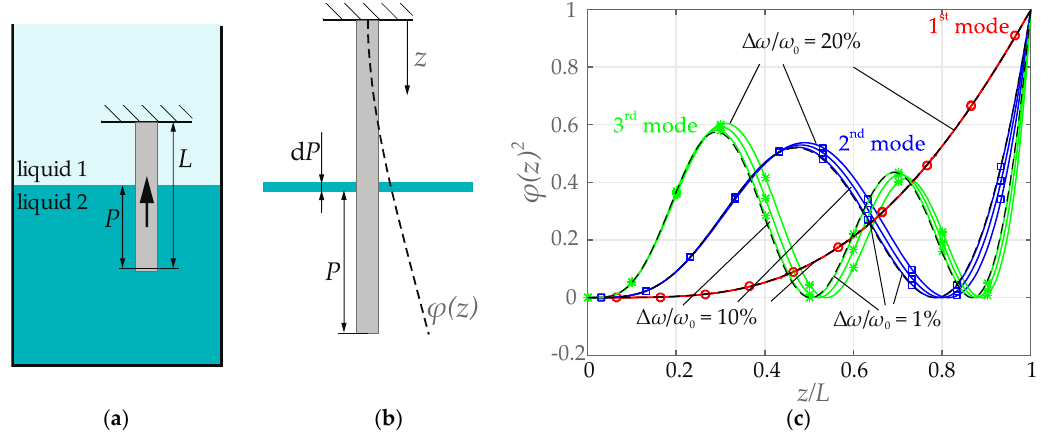
Figure 2 . ( a ) A resonator is moved from liquid 2 to liquid 1; ( b ) From the recorded frequency shift, the influence function (i.e., the squared mode shape) of an infinitely thin liquid layer at a certain height P can be determined; ( c ) Comparison between Equation (4) and the eigenmodes of a free vibrating